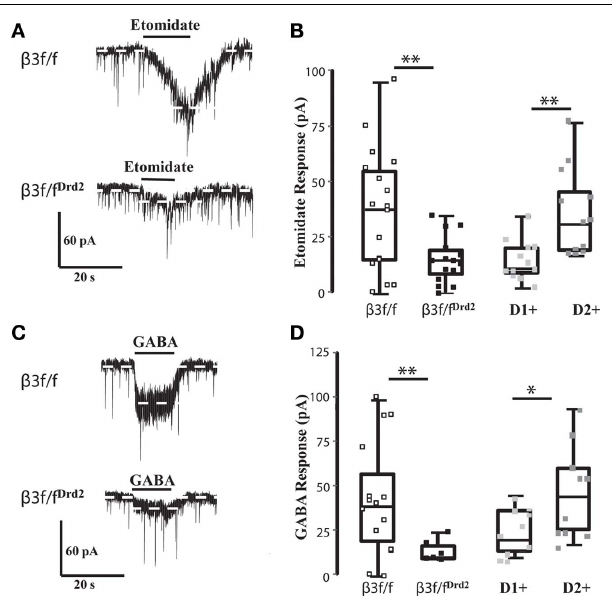
FIGURE 3 | β 3 GABA A receptor subunit affects GABA sensitivity. (A) Representative traces of etomidate (3 μ M) responses inTTX (0.5 μ M) from β 3f/f (top) and β 3f/f Drd2 (bottom) mice. (B) Summary box and whisker plots showing effects of etomidate inTTX from 3 β 3f/f (open square; n = 17), 5 β 3f/f Drd2 (black; n = 15), and 6 BAC-Drd2-EGFP; Drd1a-tdTomato mice with D1 + (light gray; n = 12) and D2 + (dark gray; n = 12) neurons. (C)